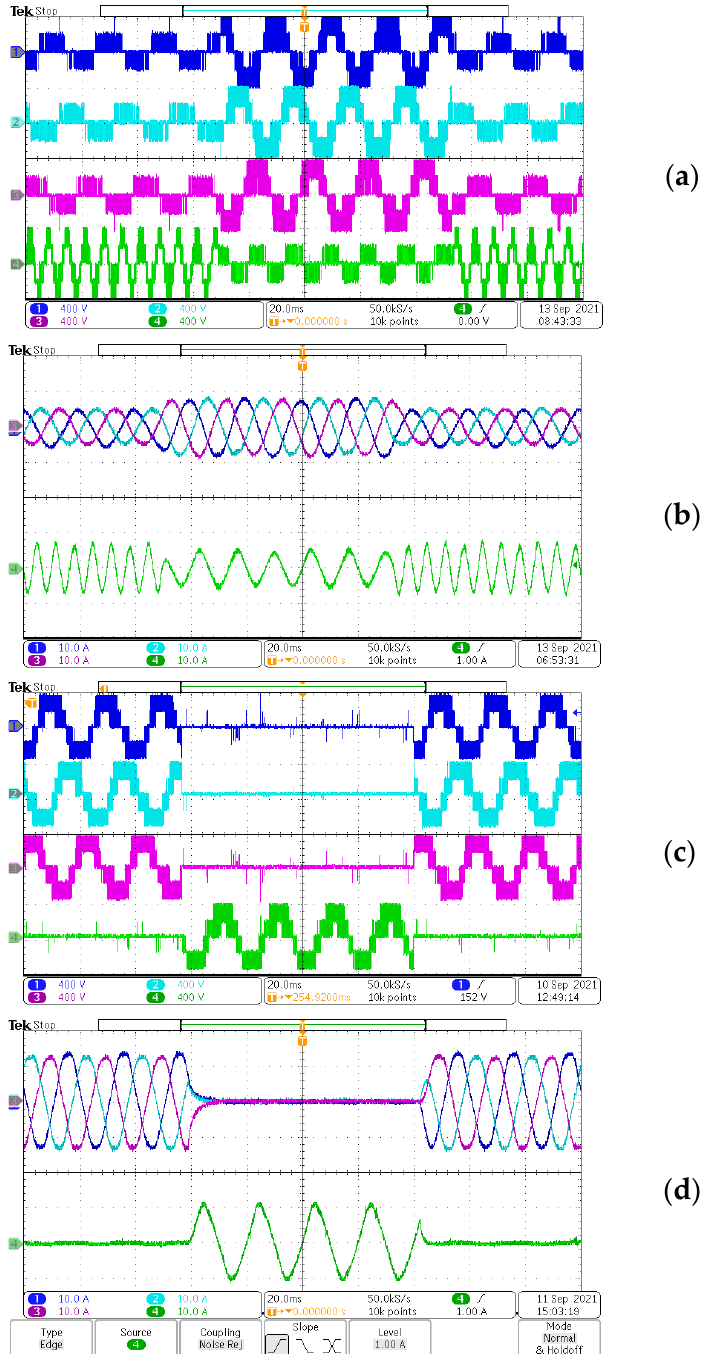
Figure 10. Experimental output voltage and current waveforms of the dual-phase inverter for different frequencies and modulation indices. ( a , b ) Output voltage and current waveforms for frequencies and modulation indices for inverters 1 and 2 of: 50 and 150 Hz, with modulation indices of 0.35 and 0.8 (50 Hz), and 50 and 75 Hz, with modulation indices of 1.05 and 0.25; ( c , d ) either operation of the two inverters at a common frequency of 50 Hz and modulation indices of 1.1547 and 1.